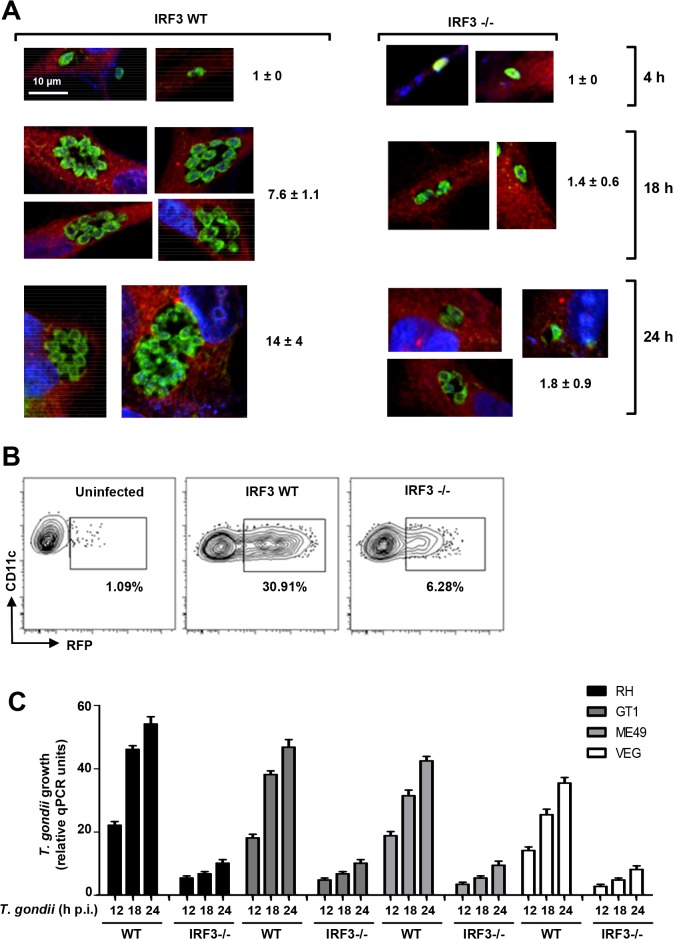
IRF3 facilitates intracellular T. gondii replication regardless of parasite virulence type.
A, Stunted parasite replication in IRF3 -/- cells. Isogenic wild type and IRF3 -/- MEF cells were infected by T. gondii RH at an m.o.i. of 0.2, and at the indicated times (4, 18, 24 h) stained for parasites (green), cytoplasmic actin (red) and nucleus (DAPI, blue) and visualized by confocal microscopy. For each sample, several individual PVs are shown; number of parasites in 12–14 PVs was counted and the mean ± SD values are shown. B, Flow cytometry measurement of parasite growth. DCs isolated from wild type and IRF3 -/- mice were infected with T. gondii RH at 0.3 m.o.i., and cells were permeabilized and dual-stained for CD11c and parasitic SAG1 at 18 h post-infection, with uninfected wild type cells as control. Gating was set to count infected cells with 2 or more parasites per PV, as marked by contour plot (left), and the percentage of such cells in the total population is shown. C, IRF3 is important for optimal growth of diverse T. gondii strains. The indicated T. gondii strains, represented the three major types: GT1 (type I), ME49 (type II), and VEG (type III). Infection was performed as in Fig. 1A, and total DNA was isolated at the indicated times. The amount of T. gondii DNA was quantified by qPCR of the genomic DNA as in Fig. 1.